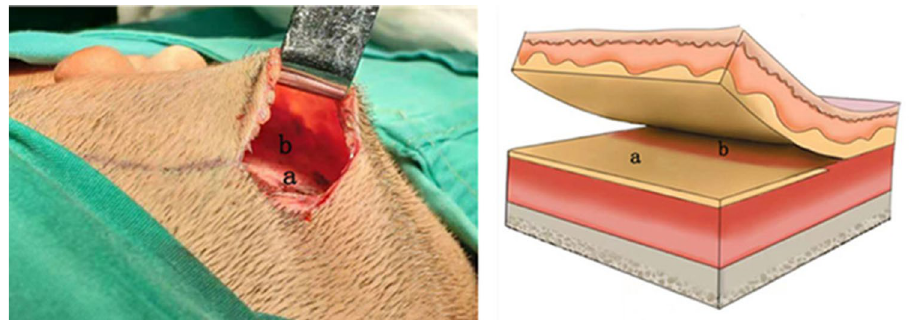
Figure 2. Schematic diagram of the dissection layers in the biplanar surgical method. a: The superficial fascial surface. b: The deep surface of the superficial fascia.